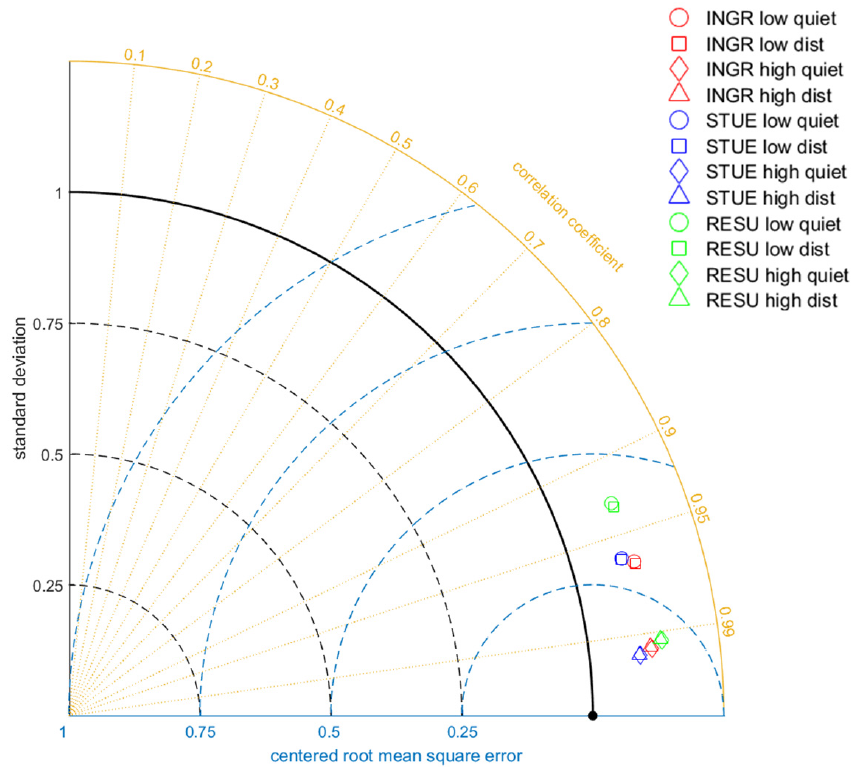
Figure 10. Taylor diagram summarizing the main statistical parameters of the considered datasets. Black y -axis represents the standard deviation of each TEC GIM dataset normalized to the corre- sponding TEC CIR dataset. Blue x -axis reports the normalized (or centered) root mean square error and the orange circular curve represents the correlation coefficient. Red, blue and green symbols identify the datasets related to INGR, STUE and RESU respectively. Different symbols show different combinations of solar (low and high) and geomagnetic (quiet and disturbed) conditions. Even though values of the difference TEC GIM –TEC CIR are higher for HSA, the highest precision (related to the standard deviation) and accuracy (related to NRMSE) of TEC GIM is reached during HSA, for both quiet and disturbed conditions. This feature slightly de- grades moving from north to south. For LSA, it can be noted that the accuracy is consid- erably lower in the southern station RESU.